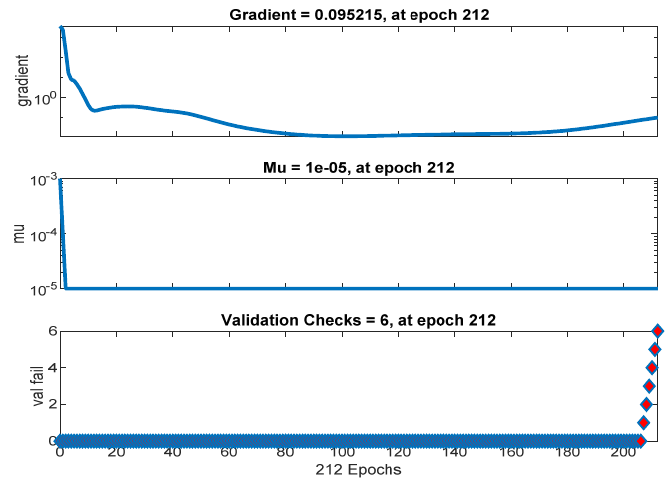
Figure 12. ANN training.